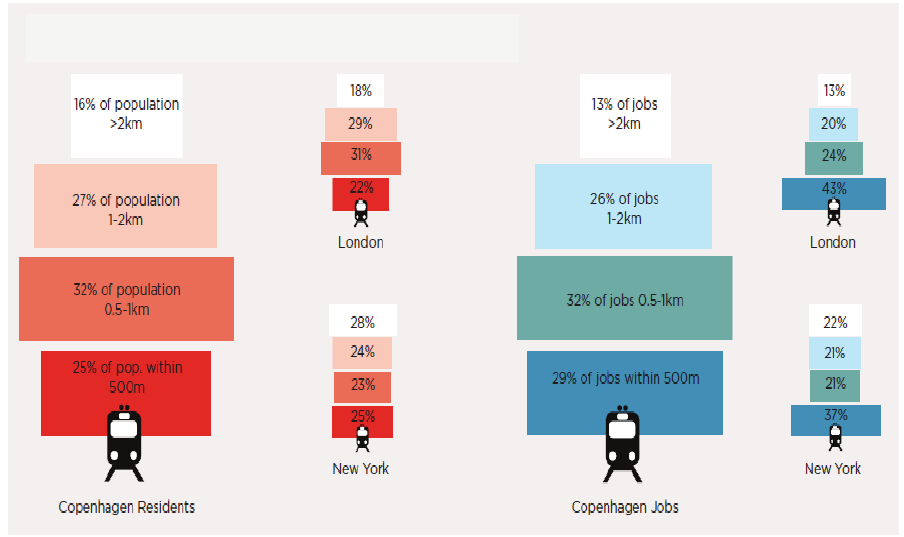
Figure 2: Copenhagen pedestrian accessibility to rail and metro